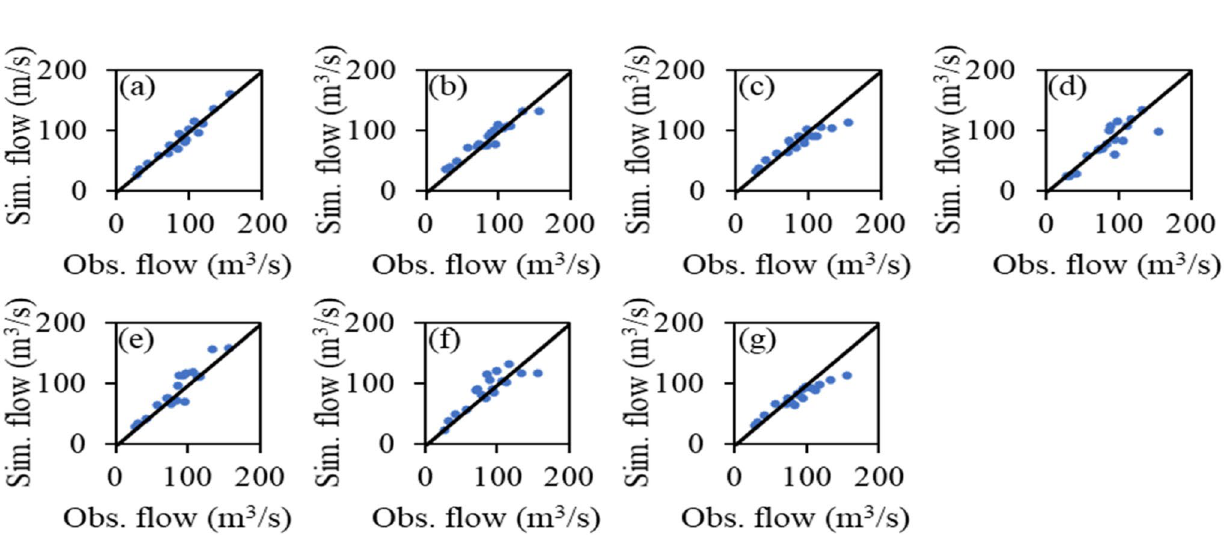
Fig. 6 Model performance assessment based on comparison of observed and simulated annual maxima flows in each year for a AWBM, b SAC, c TANK, d IHACRES, e SIMHYD, f SMAR, g HMSV, Sim. stands for simulated, while Obs. means observed